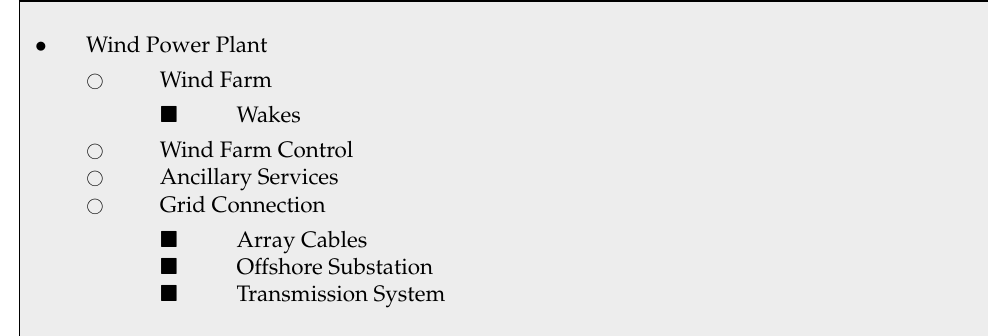
Table 14. Hierarchy for Economics-related topics in the Production of Electricity from Wind Power.